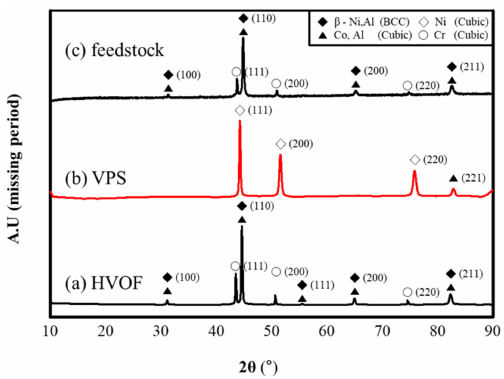
Figure 2. XRD results of as-coated ( a ) HVOF ( b ) VPS and ( c )